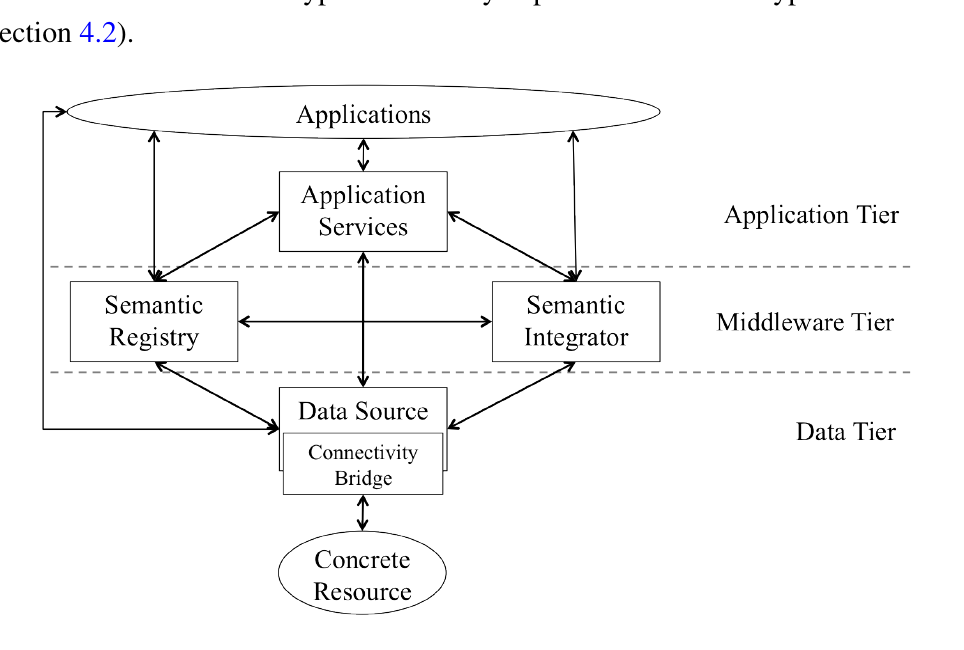
Table 1. Functionality provided by the service interfaces. The use of existing standard interfaces is depicted in brackets. (Note that a mapping can be passed into the integration interface which relates the models of the data provided by the data sources to the global model of the data used by the integrated data